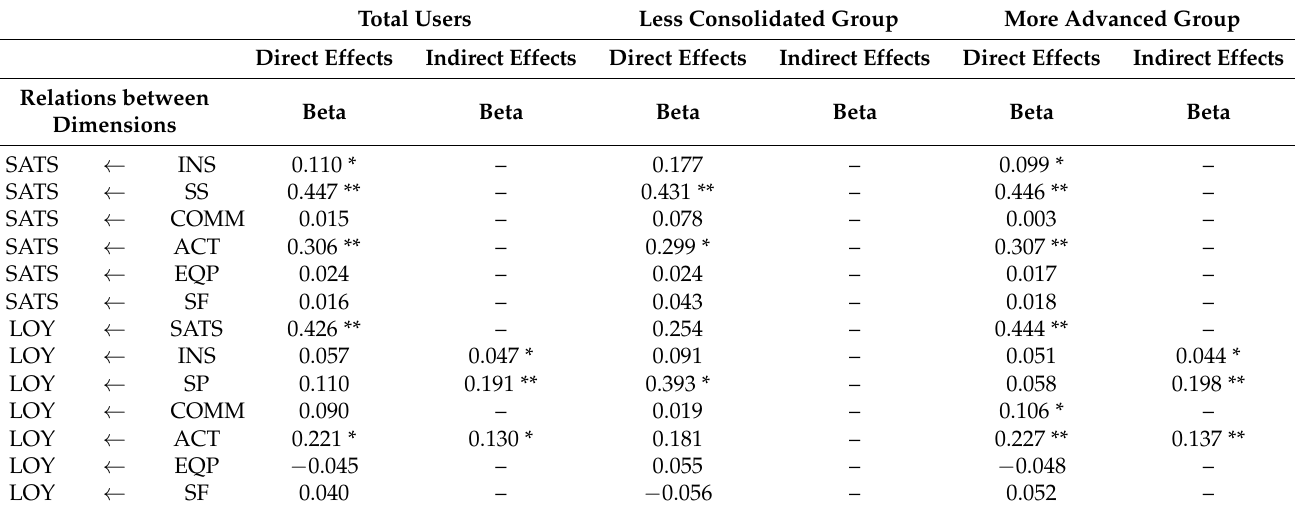
Table 4. Comparison between standardised and unstandardised regression coefficients and significance levels of the two groups of users aged